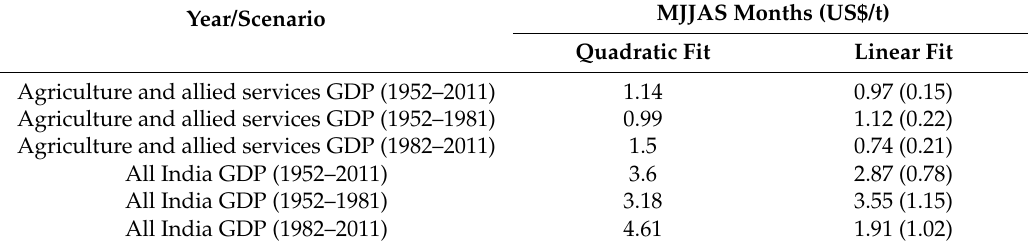
Table 8. Cost on economy of the SO 2 emissions from burning one tonne of Indian coal according to the total cost of the emissions and the SO 2 emissions of coal burning for both a quadratic and a linear relationship between ISMR and GDP, with uncertainties presented as per Table